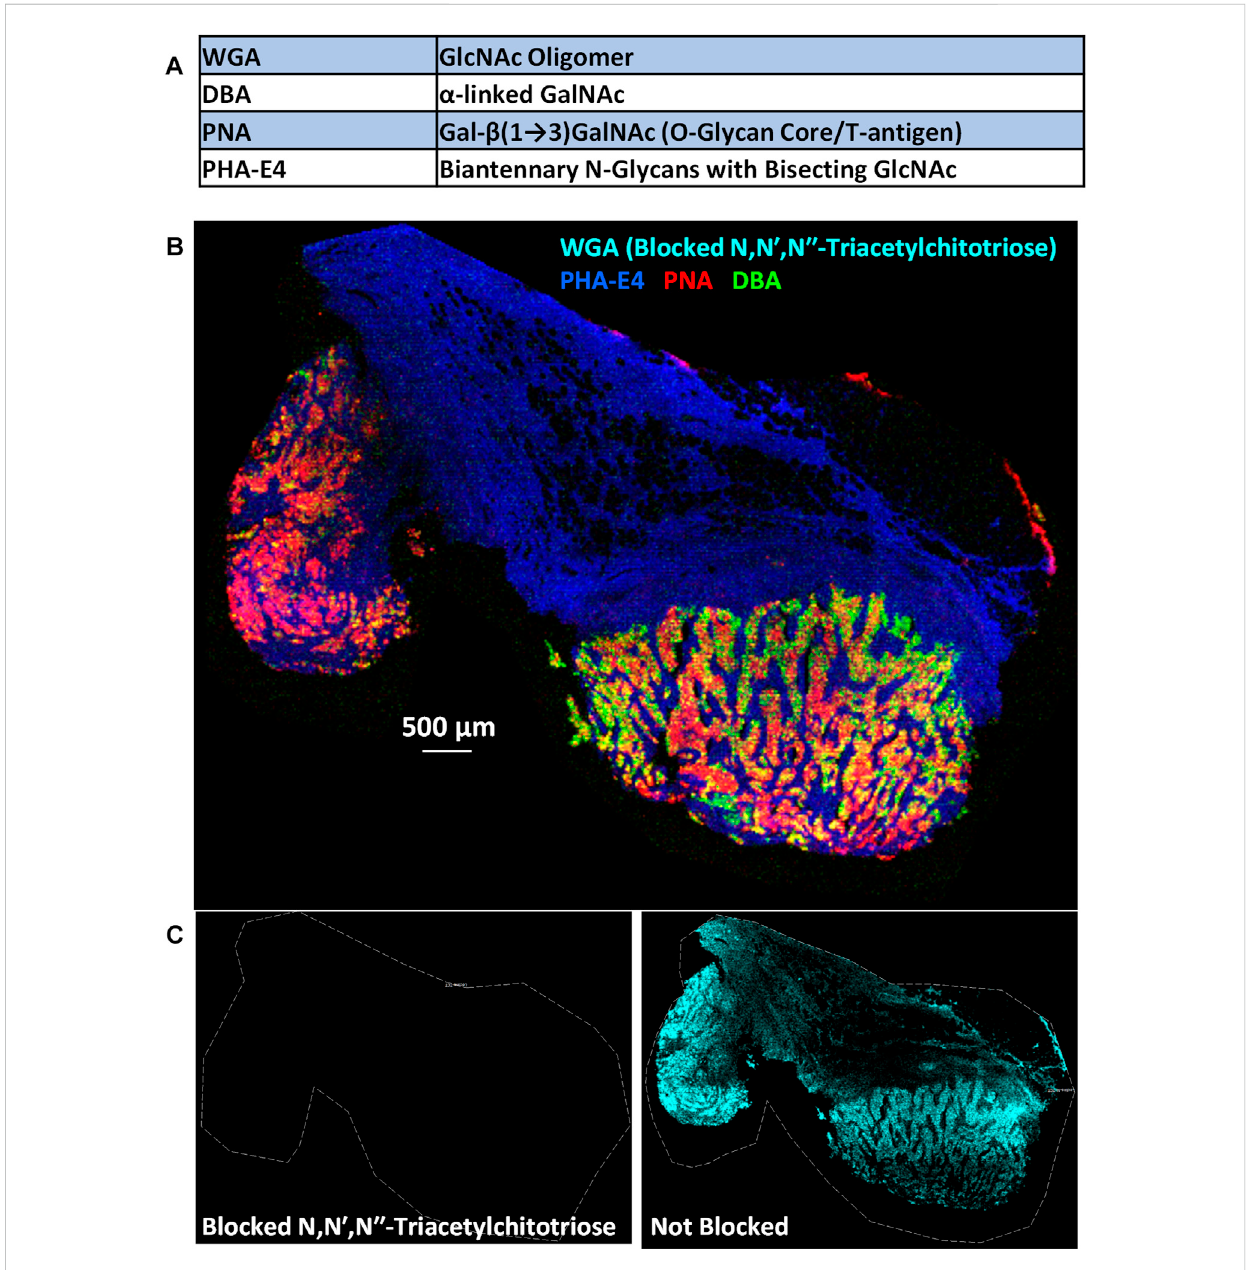
FIGURE 6 Mass spectrometry imaging of glycans in an FFPE breast cancer specimen using PC-MT lectin probes. (A) 4-Plex PC-MT lectin panel used and their carbohydrateselectivity. (B) MALDI-MSimageofthefourPC-MTlectinsontheFFPEbreastcancerspecimen(seecolorkeyinimage).Toshowspeci fi city of lectin binding (of WGA in this case), the mixture of PC-MT lectin probes was spiked and pre-incubated with the soluble sugar N,N ′ ,N ′′ -Triacetyl- chitotriose (TCT) which speci fi cally binds WGA. (C) WGA image alone with the TCT blockade (left) and without the TCT blockade on an adjacent (serial) tissue section on the same slide